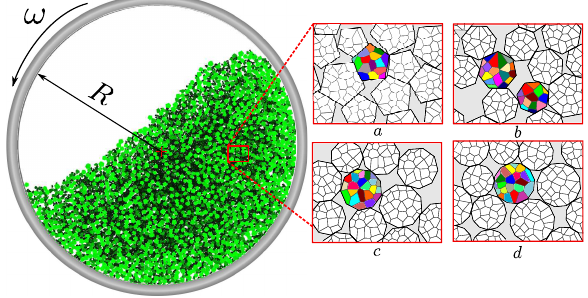
Figure 1. Geometry parameters of the simulated drum in 2D. The colors of the particles are proportional to the damage rang- ing from bright green for intact particles to black for completely broken fragments. The zoom windows show the initial state of di ↵ erent samples with n sides = a) 5, b) 7, c) 9, and d) 12. Each cell is represented with a di ↵ erent color.